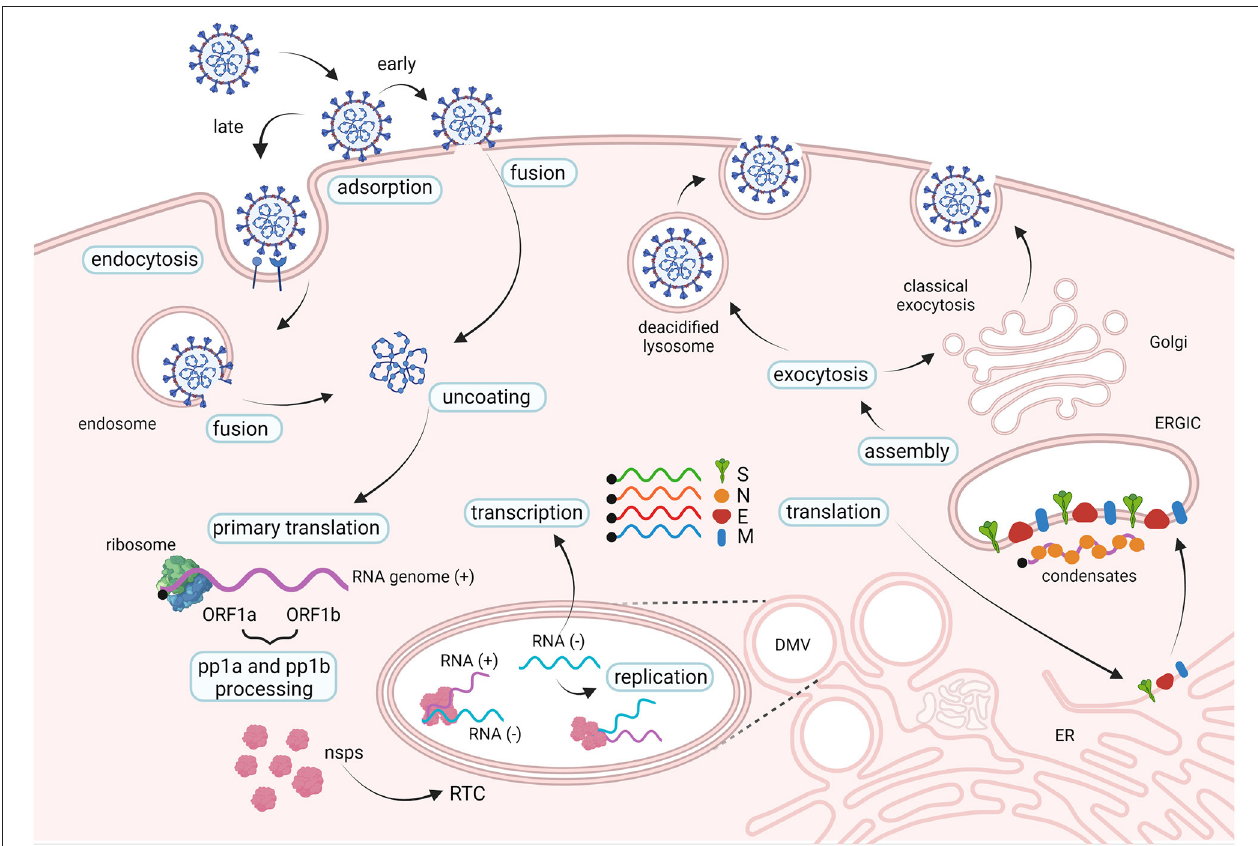
FIGURE 3 | The life cycle of SARS-CoV-2. SARS-CoV-2 interacts with cellular receptors such as human angiotensin-converting enzyme 2 (hACE2) and with host proteases which activate the spike proteins (not shown). Entry in the cell cytoplasm may occur in two ways: the viral particle is endocytosed before fusing with the endosomal membrane (late pathway), or the viral membrane fuses with the cell membrane at the cell surface (early pathway). Two large open reading frames, ORF1a and ORF1b, are immediately translated in polyproteins pp1a and pp1ab, that are processed into the individual non-structural proteins (nsps) which form the viral replication and transcription complex (RTC). Viral genomic RNA replication occurs in protective double-membrane vesicles (DMVs). Transcription and translation of the negative template result in the formation of structural proteins that are inserted into the endoplasmic reticulum (ER) membrane and transit through the ER-to-Golgi intermediate compartment (ERGIC). Here, condensates of newly produced genomic RNA and N proteins interact with E and M proteins resulting in assembly of viral particles, which bud into the lumen of secretory vesicular compartments. Virions are secreted from the infected cell by exocytosis in two ways: through the classical exocytosis pathway via the Golgi compartment or through the incorporation in deacidified lysosomes that fuse with the cellular surface membrane.